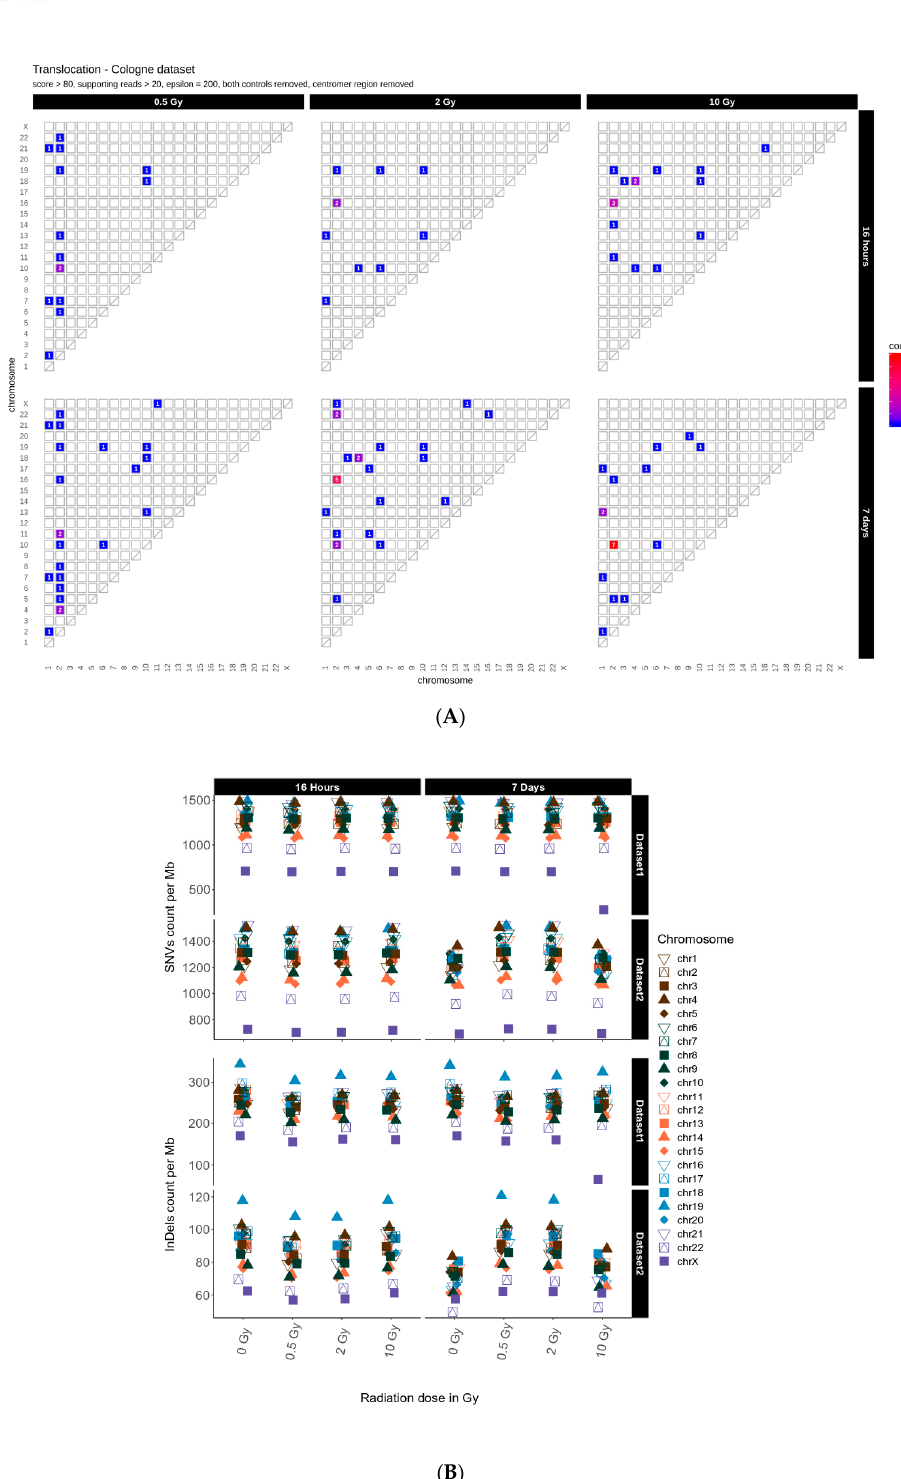
Figure A1. ( A ): Translocation counts between chromosomes (irrespective of the direction) in genome dataset 2 (generated with BreakDancer.). ( B ): Overview for genome dataset 1 and dataset 2 showing accumulation of SNVs per Mb (upper panel) and InDels per Mb (lower panel) per chromosome for unfiltered